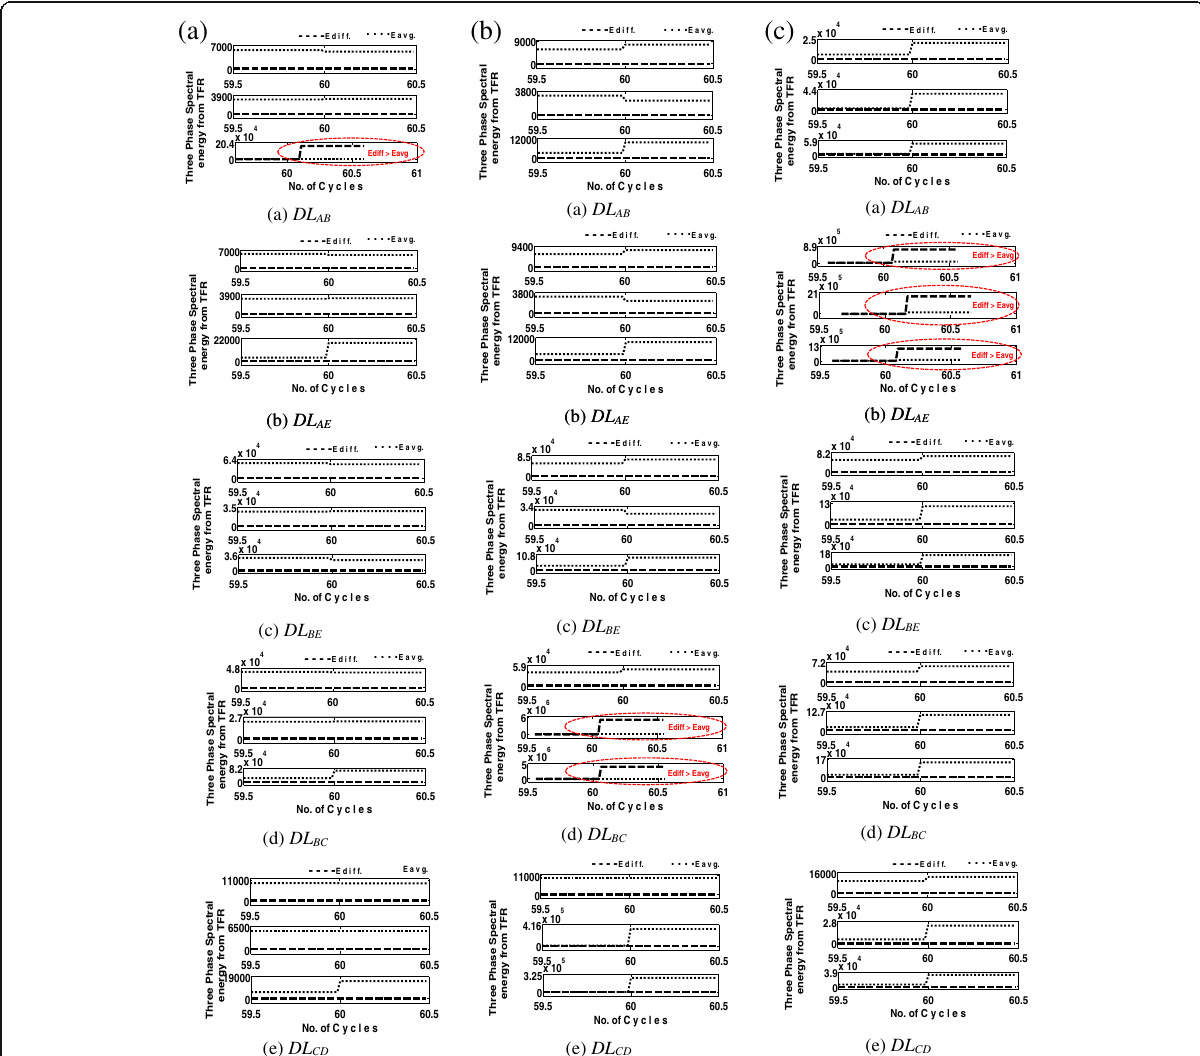
Fig. 5 a The three phase spectral energy from TFR for differential ( − – ) and average ( … .) currents, for the islanded microgrid subjected to a single phase to ground fault (c-g) on distribution line DLAB (with FDR 0.2, and Rf = 0.5 Ω ), where, responses are for distribution lines ( a ) DLAB, ( b ) DLAE, ( c ) DLBE, ( d ) DLBC and ( e ) DLCD, respectively. b The three phase spectral energy from TFR for differential ( − – ) and average ( … .) currents, for the islanded microgrid subjected to a double phase to ground fault (bc-g) on distribution line DLBC (with FDR 0.6, and Rf = 5 Ω ), where, responses are for distribution lines ( a ) DLAB, ( b ) DLAE, ( c ) DLBE, ( d ) DLBC and ( e ) DLCD, respectively. c The three phase spectral energy from TFR for differential ( − – ) and average ( … .) currents, for the islanded microgrid subjected to a triple phase to ground fault (abc-g) on distribution line DLAE (with FDR 0.8, and Rf = 20 Ω ), where, responses are for distribution lines ( a ) DLAB, ( b ) DLAE, ( c ) DLBE, ( d ) DLBC and ( e ) DLCD,